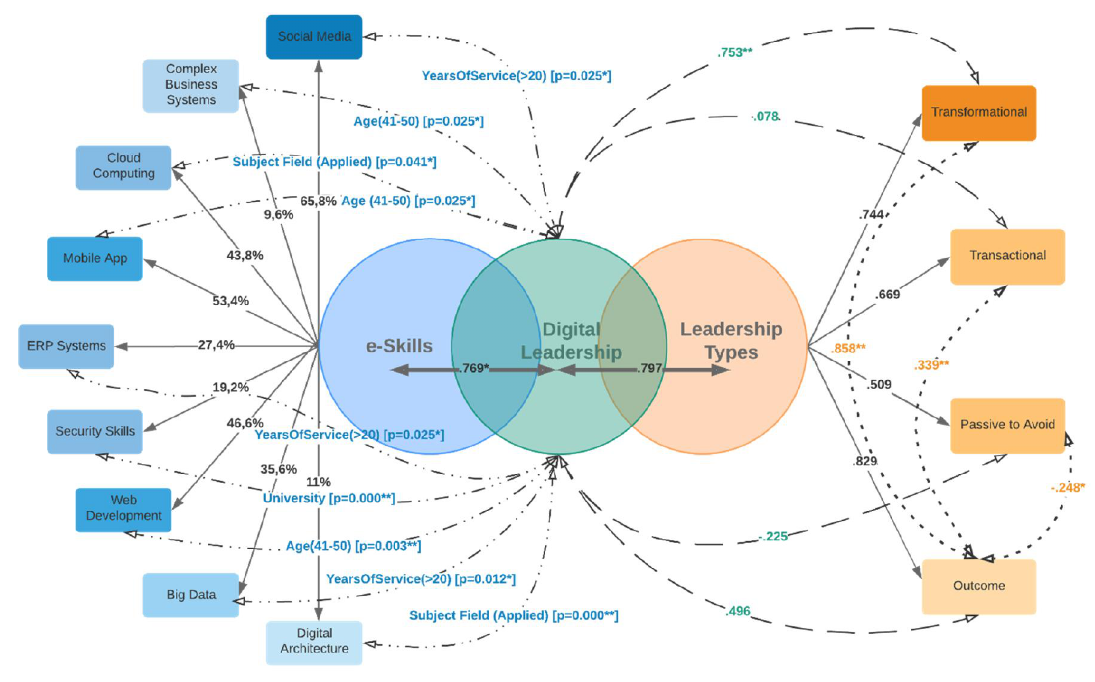
Figure 11. Final model with significant pathways of focused variables. *p< .05 | **p<